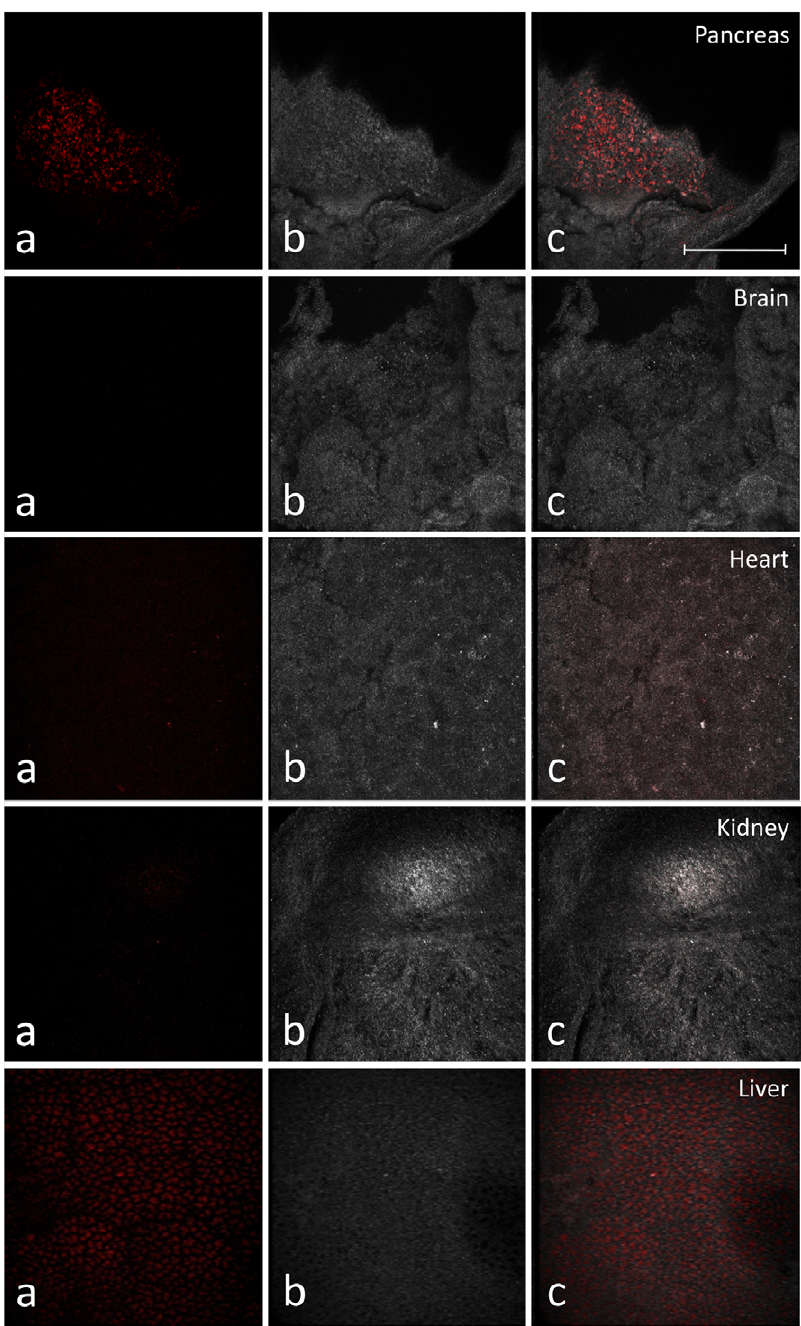
Figure 3. In vivo penetrability of TAT-fused proteins after in utero intra-cardiac injection. Examined organs are indicated. A, B and C represent Alexa Fluor 568-labeled TAT- b MafA (red), phase contrast of tissue, and composite image, respectively. Images were obtained 4 h after the injection by two-photon confocal microscopy. Size bar: 500 m m.